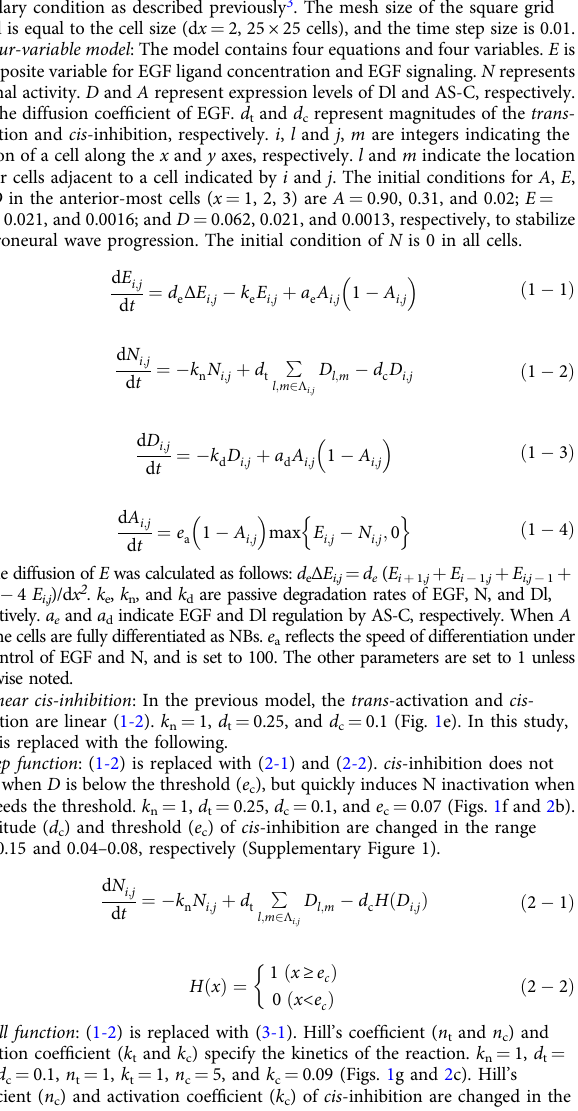
Fig. 7 The second Notch peak regulates the temporal patterning of neurogenesis. a Klu expression (magenta) coincides with the second peak of N activity (m γ GFP, green) as indicated by arrows behind the wavefront (Lsc, blue). b Klu expression (magenta) is eliminated in Dl mutant clones visualized by the absence of GFP (green), except for cells at the clone boundary (arrows). Lsc visualizes the accelerated wavefront inside the Dl mutant clones (blue). c , d Fusion of the twin peaks of N activity (m γ GFP, green) and precocious Klu expression (magenta) indicated by arrows upon partial knockdown of Dl ( c ) and vps2 ( d ). Asterisks indicate the optix-Gal4 -positive areas outlined by white lines. Yellow lines outline Klu-expressing NBs. The wavefronts are not accelerated (Lsc, blue). e optix-Gal4 is expressed in the dorsal (top) and ventral (bottom) subdomains of the optic lobe (GFP, green). GFP signals are stronger in the dorsal subdomain. Run (magenta). f Cells expressing Bsh-GFP (green) and Run (magenta) form the concentric zones that are complementary with each other. g , h Ectopic Run-positive cells (magenta) are found within the concentric zone expressing Bsh-GFP (green) upon partial knockdown of Dl and vps2 as indicated by arrows. Positions of Run and Bsh-positive cells are plotted in magenta and green within the defective areas and in black and gray in the other areas, respectively, in the right panels. i Overlaps between Run- and Bsh-positive areas are quanti fi ed in Dl and vps RNAi backgrounds ( p = 0.034, 0.009 (* p < 0.05, ** p < 0.01), two-sided t test, n = 4, number of brain samples). Cross, mean; center line, median; box limits, upper and lower quartiles; whiskers, 1.5× interquartile range. j , k Morphologies of Run-positive medulla neurons, Mi4 ( j ) and TmY16 ( k ) visualized by run- Gal4 UAS-CD8GFP MARCM clones (white). Run (red) and Ncad (blue). Layers in the medulla (M), lobula (Lo), and lobula plate (Lop). l Schematics of the temporal patterning of neurogenesis through N activity and Klu expression. Hth- and Klu-positive NBs produce Bsh- and Run-positive neurons, respectively. Fusion of the twin peaks of Notch activity leads to precocious Klu expression, which precociously produces Run-positive neurons. Scale bars, 20 μ